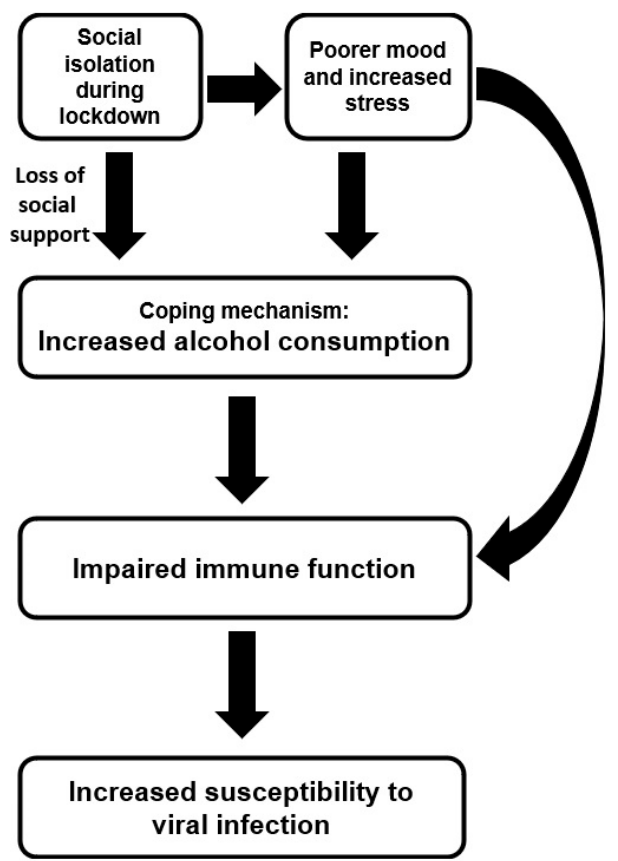
Figure 1. Schematic representation of a model explaining the role of alcohol consumption during COVID-19 lockdown.